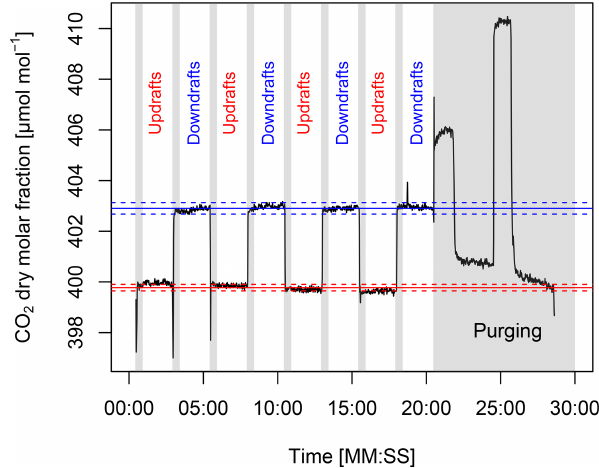
Figure 6. CO 2 dry molar fraction measured as a sequence al- ternating between updraft and downdraft reservoirs. First the up- draft reservoir was measured for 150s, then the downdraft reser- voir for 150s, discarding the initial 30s of measurements from each block. This sequence was repeated four times. During the remain- ing 10min of the 30min period any remaining air in the reservoirs was purged and not used for analysis (gray shaded area). The means of the despiked updraft and downdraft dry molar fractions are indi- cated by a red and blue solid line, respectively. The dashed lines indicate the mean ± 1 standard deviation. The start date of the time series is 10 April 2015